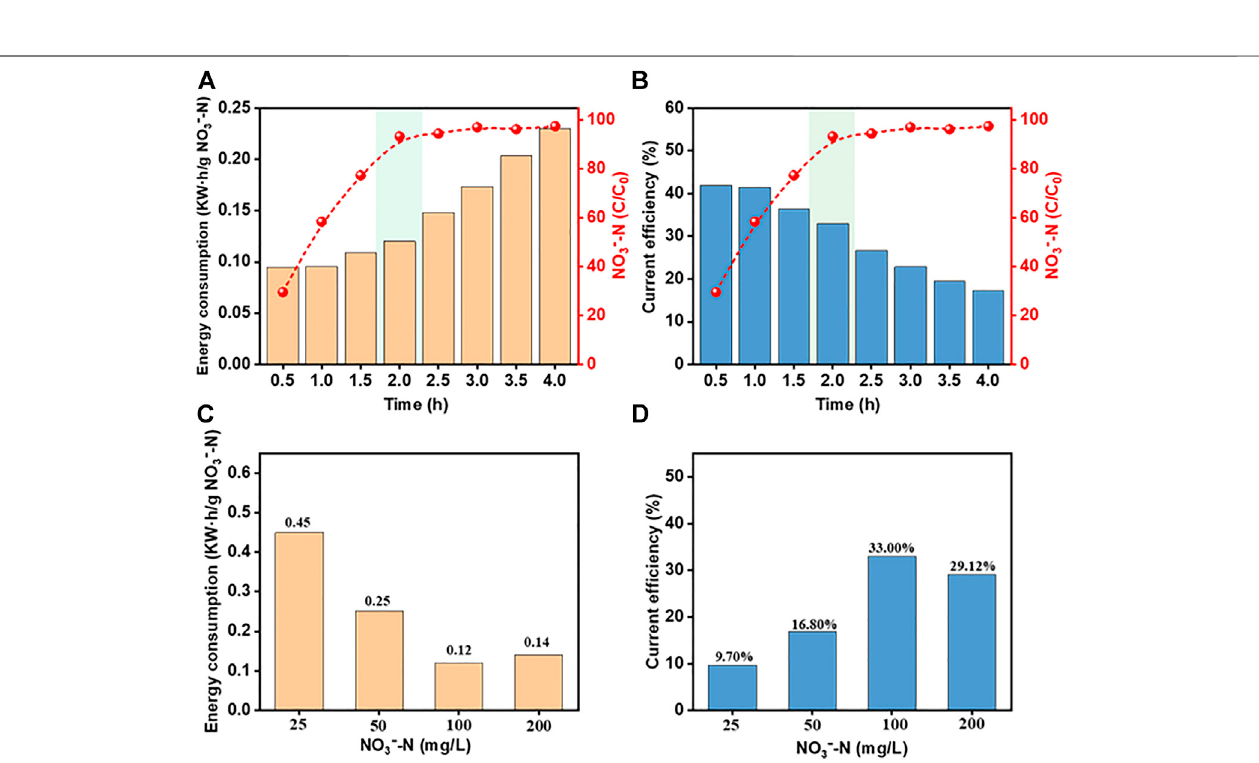
Frontiers in Chemistry |